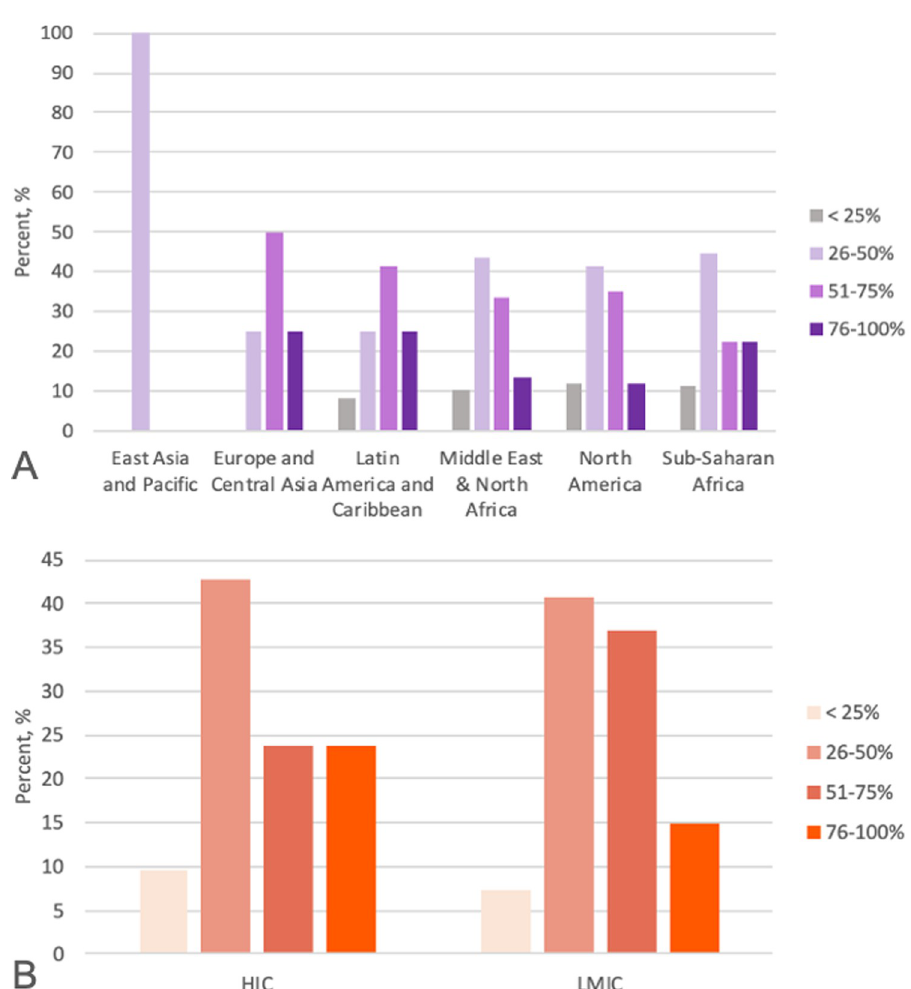
Fig 3. In your home country, what percentage of medical professionals are women? A: By volunteer home region. B: By volunteer home country income level.